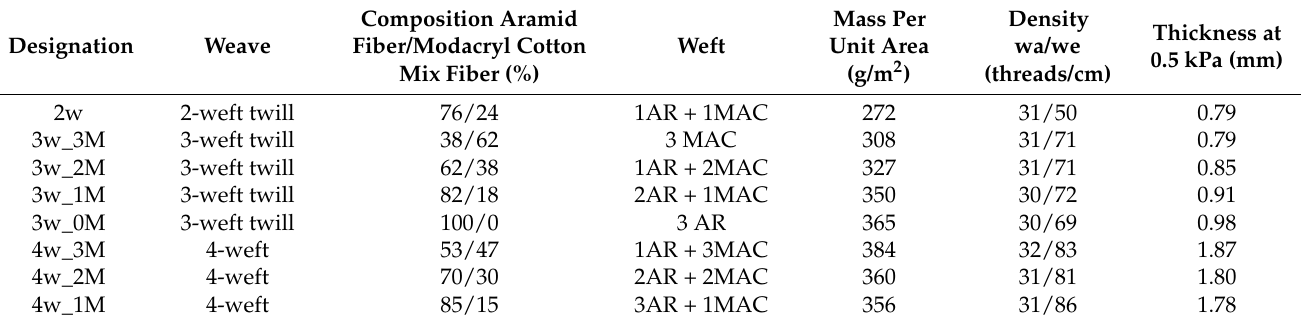
Table 2. Empirical sample parameter.